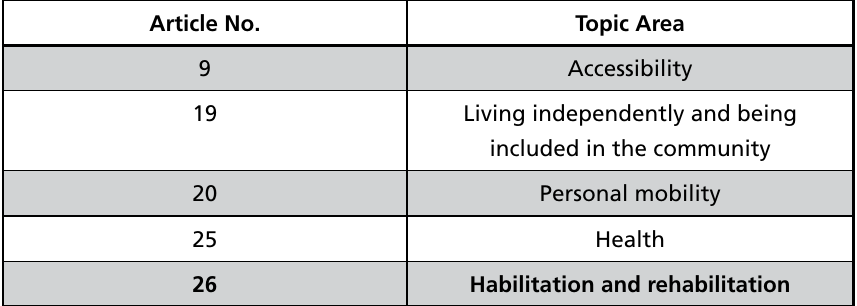
table 1: selected articles on rehabilitation from UN convention for the Rights